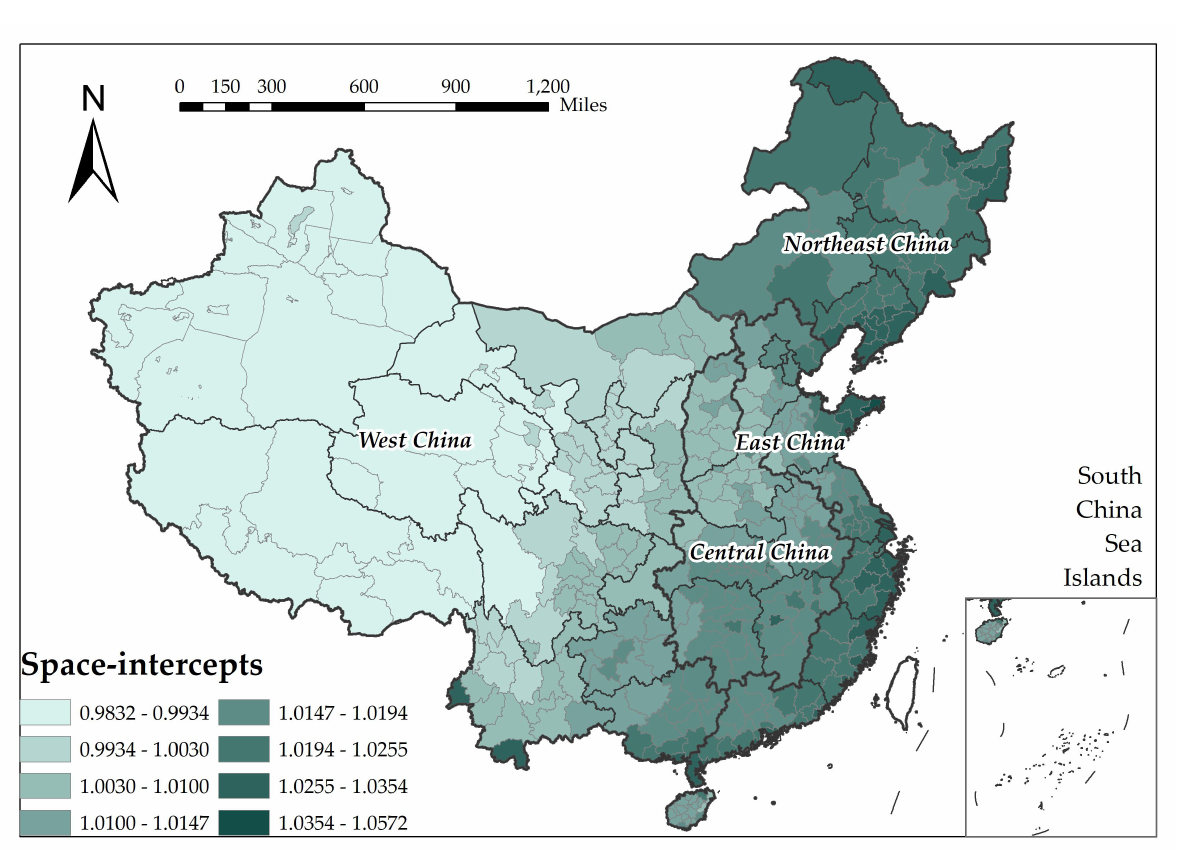
Figure A1. Space-Intercepts (SIs) map: the model-estimated geographical variations of China’s ten-year average total tourism revenue at the city level during